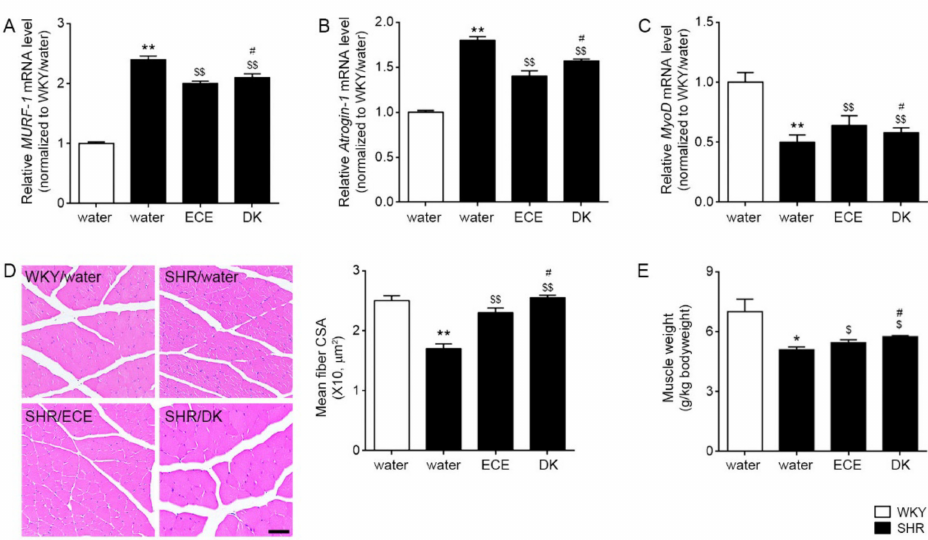
Figure 4. Regulatory effects of ECE and DK on muscle degradation and muscle atrophy of SHRs. ( A , B ) The expression levels of MURF-1 and MAFbx/atrogin-1 in muscle were increased following SHR/water and decreased following ECE or DK treatment. ( C ) The expression levels of MyoD in muscle decreased following SHR/water and increased following ECE or DK treatment. The mRNA levels were measured by qRT-PCR, normalized versus actb , and expressed relative to the WKY/water group levels. ( D ) The cross -sectional area of the muscle fiber was decreased following SHR/water and